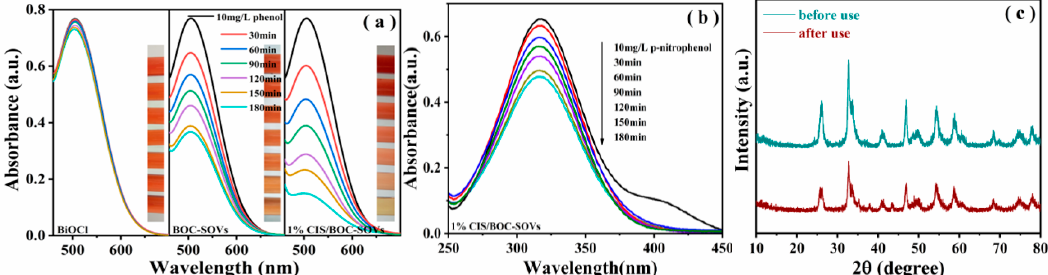
Figure 9. Removal and temporal evolution of UV-Vis absorption spectra of ( a ) phenol and ( b ) p-nitrophenol over different catalysts, ( c ) XRD pattern of 1% CIS/BOC-SOVs before and after use.